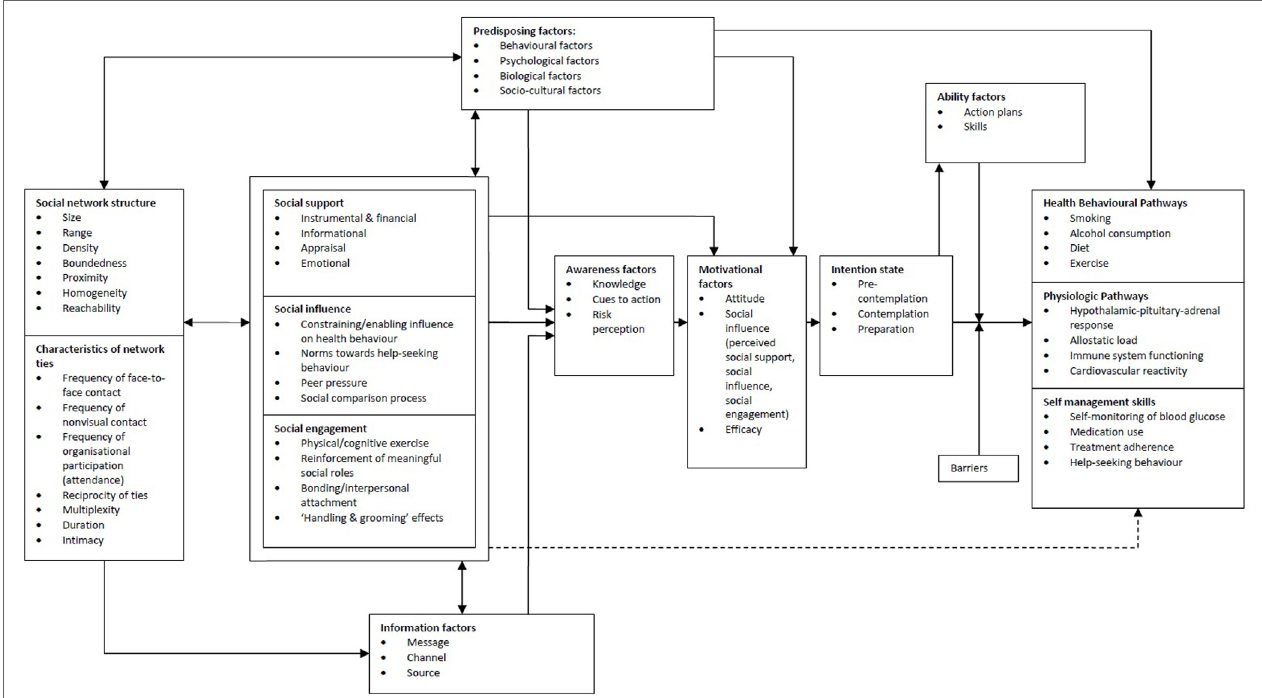
FigUre 2 | The I-Change model combined with the social network model of Berkman and Kawachi (50).